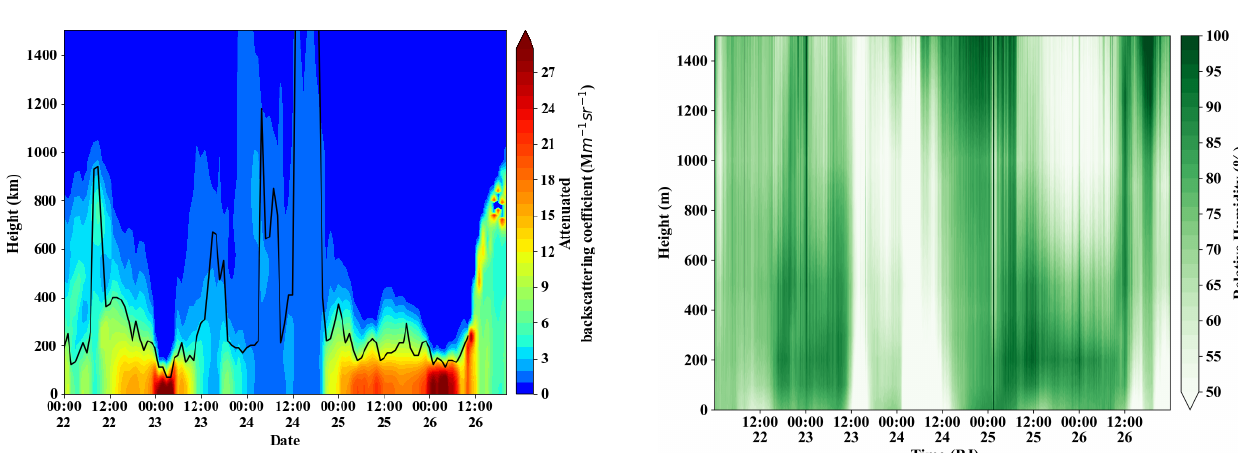
Figure 16. Vertical relative humidity profile of Beijing at 08:00 and 20:00CST from 22 to 26 December 2015 in the Beijing observatory (39.93 ◦ N, 116.28 ◦ E) (unit: